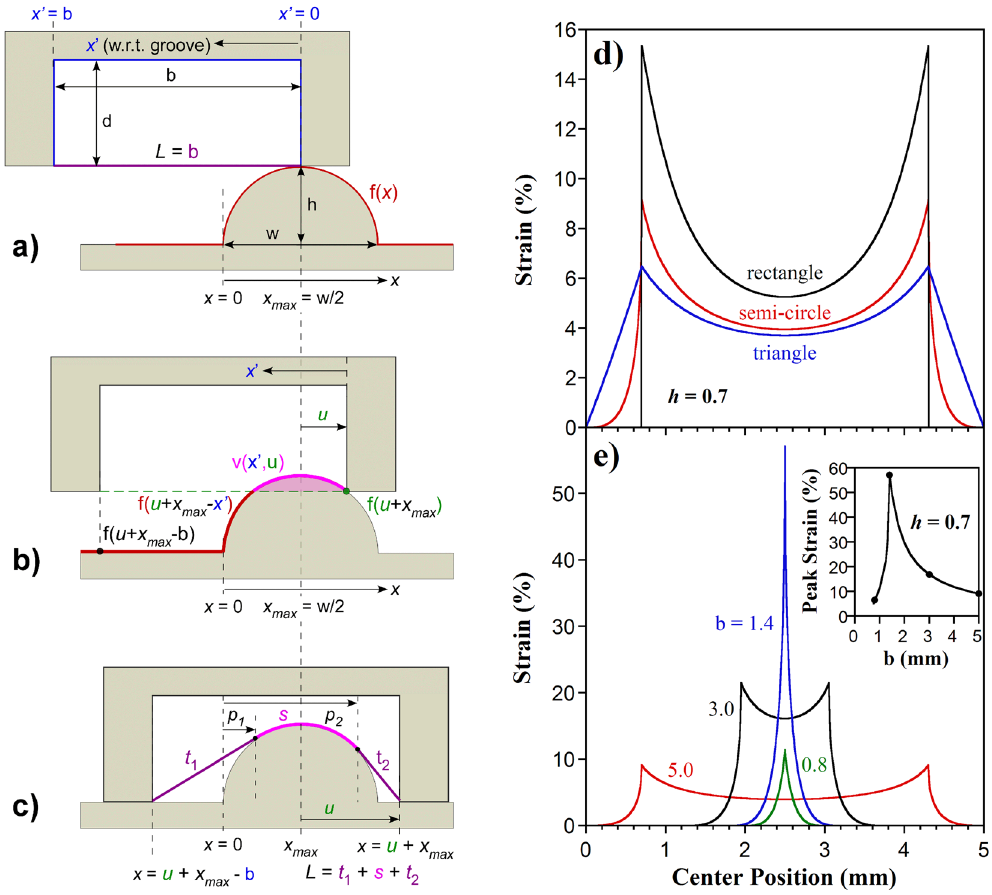
Figure 5. ( a ) Illustration of the mathematical model for a semicircular feature shorter and narrower than a notch. The notch begins at the highest point on the feature and moves an amount 0 < u < b in the x -direction. Coordinates with respect to the groove are given in the moving coordinate system x ′ . ( b ) As the notch moves, the feature penetrates into it as described by v ( x ′ , u ). ( c ) The stretched membrane has a region in contact with the feature and may have one or two regions that are suspended. ( d ) Model predictions of sensor strain as a function of feature position for three different feature shapes, all with width w = 1.4 mm and height h = 0.7 mm, within a rectangular notch of breadth b = 5 mm and depth d > 0.7 mm. ( e ) Predictions for a semi-circular feature of w = 1.4 mm and h = 0.7 mm in 4 notch breadths: 5, 3, 1.4, and 0.8 mm. (inset) Peak strain as a function of notch breadth, showing nonlinear amplification. The points indicate the four cases shown in ( e